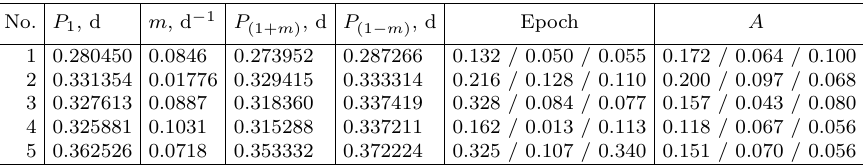
Table 2. Equidistant triplets: light elements and